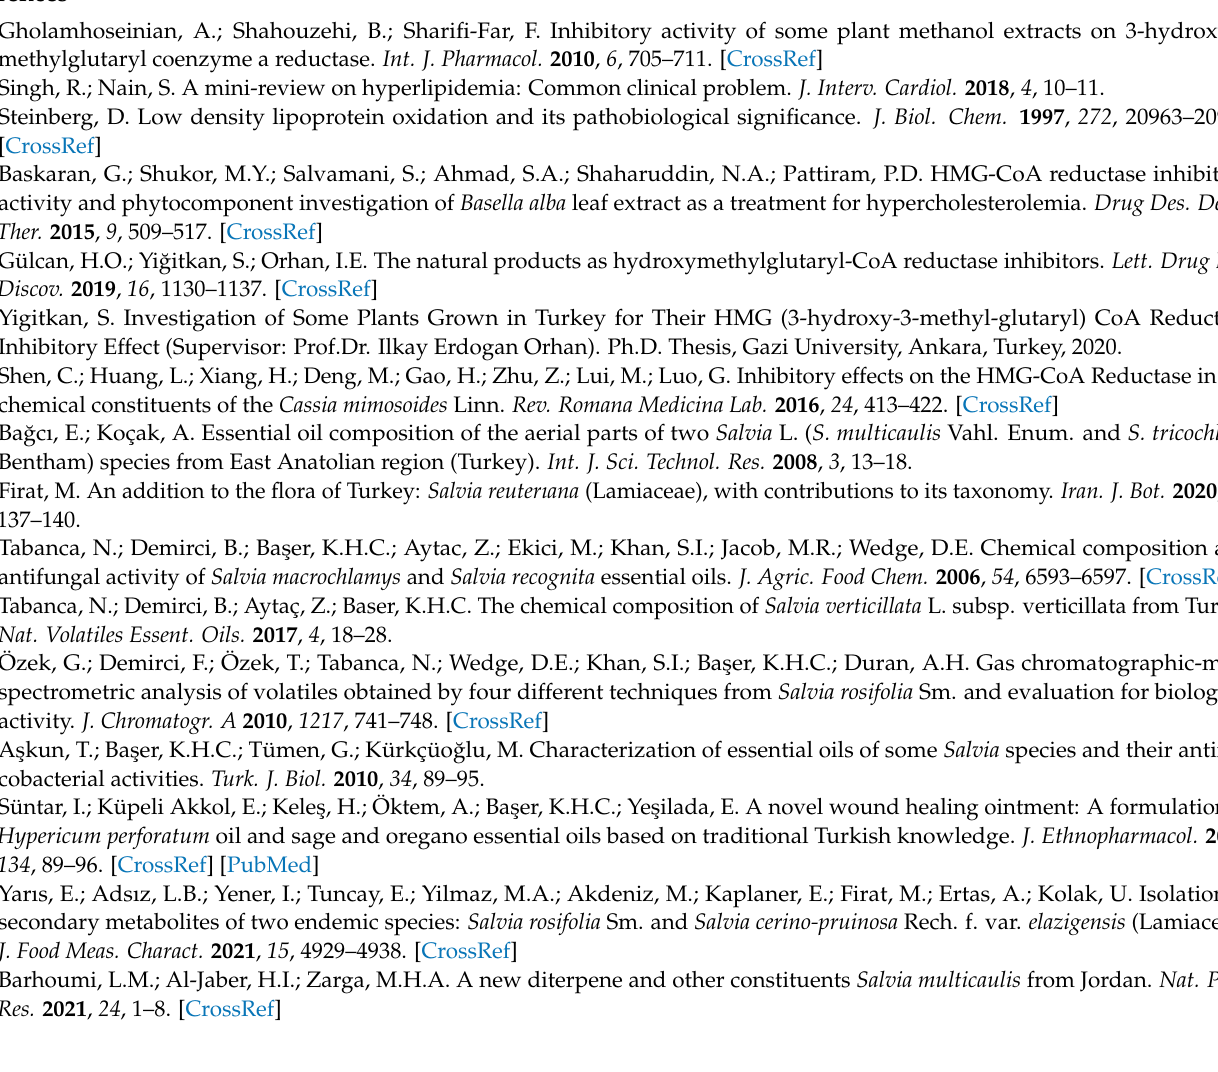
Figure S46. HMBC spectrum of 9 in CD 3 OD (600 MHz), Figure S47. HMQC spectrum of 9 in CD 3 OD (600 MHz), Figure S48. LC-MS-IT-TOF spectrum of 9, Figure S49. 1 H NMR spectrum of 10 in CD 3 OD (600 MHz), Figure S50. 13 C NMR (APT) spectrum of 10 in CD 3 OD (600 MHz), Figure S51. HMBC spectrum of 10 in CD 3 OD (600 MHz), Figure S52. HMQC spectrum of 10 in CD 3 OD (600 MHz), Figure S53. LC-MS-IT-TOF spectrum of